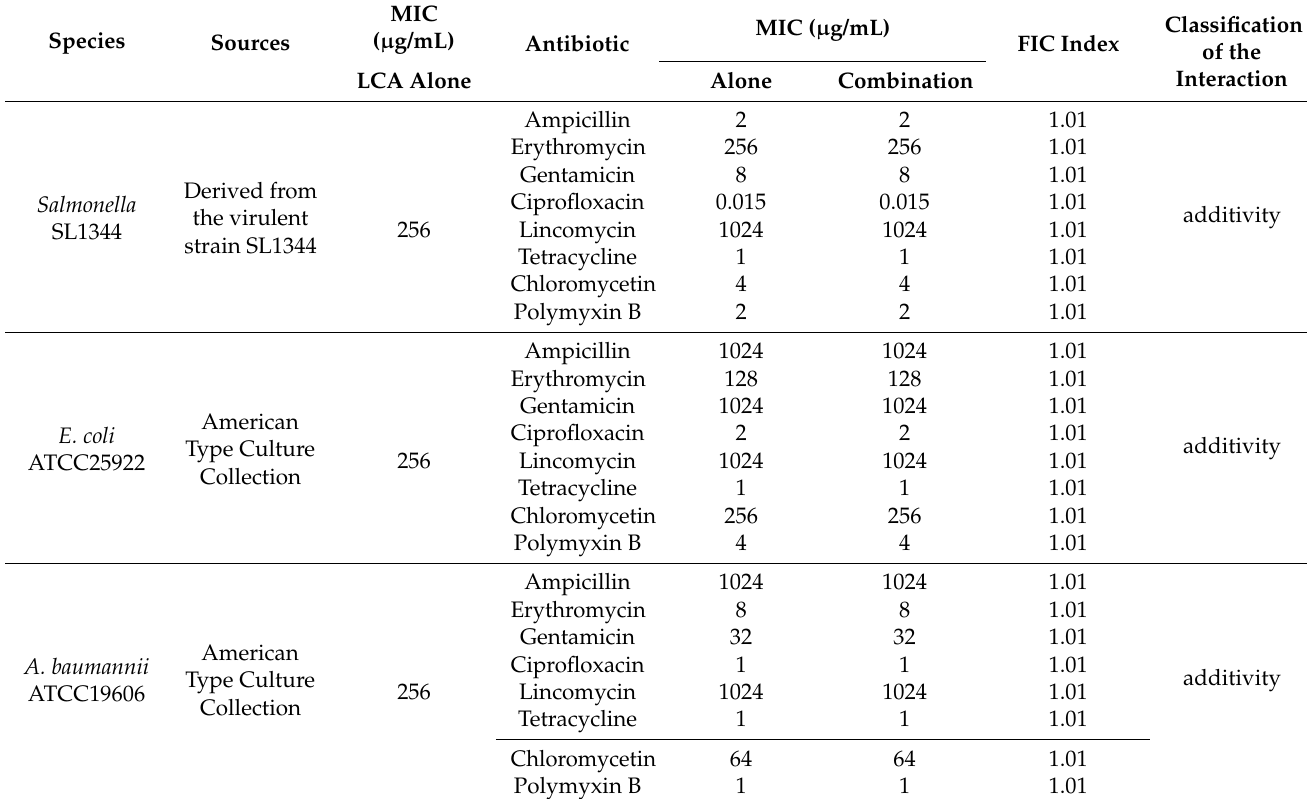
Table 2. The MIC and FIC index determination of LCA combined with different antibiotics against Gram-negative bacteria.